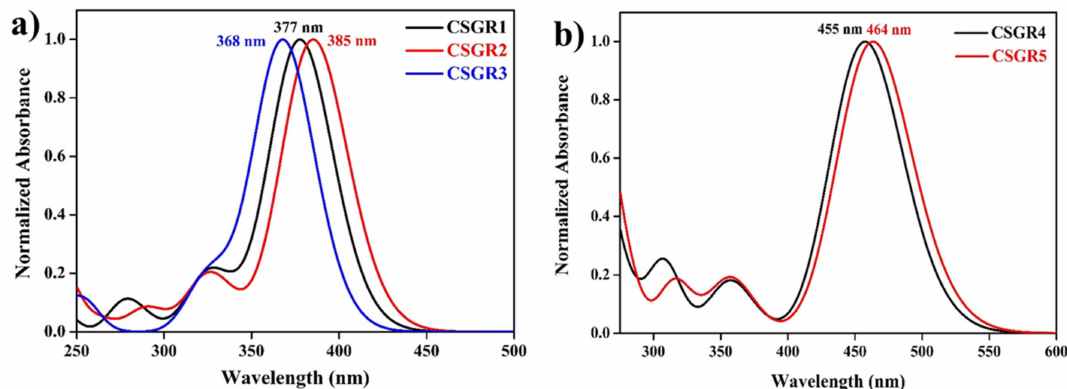
Figure 10. Simulated UV-visible absorption spectra of the dyes CSGR1 to CSGR5 obtained in DMF solvent at TD-CAM-B3LYP / 6-31G(d) level of